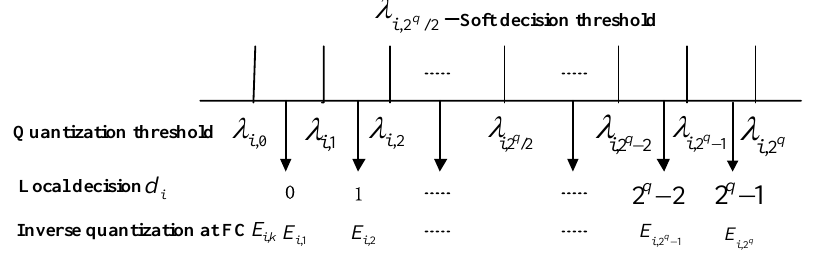
Figure 3. Proposed q -bit quantizer.